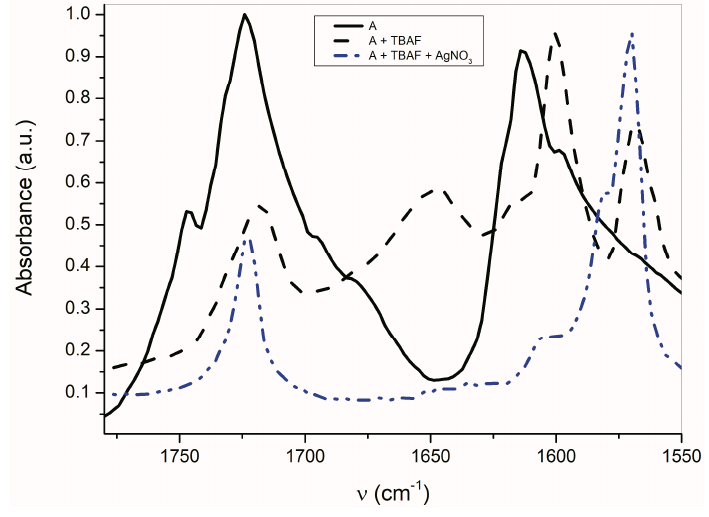
Figure 6. Effect of TBA + and Ag + on A -azanion FTIR spectrum (ATR spectra) .